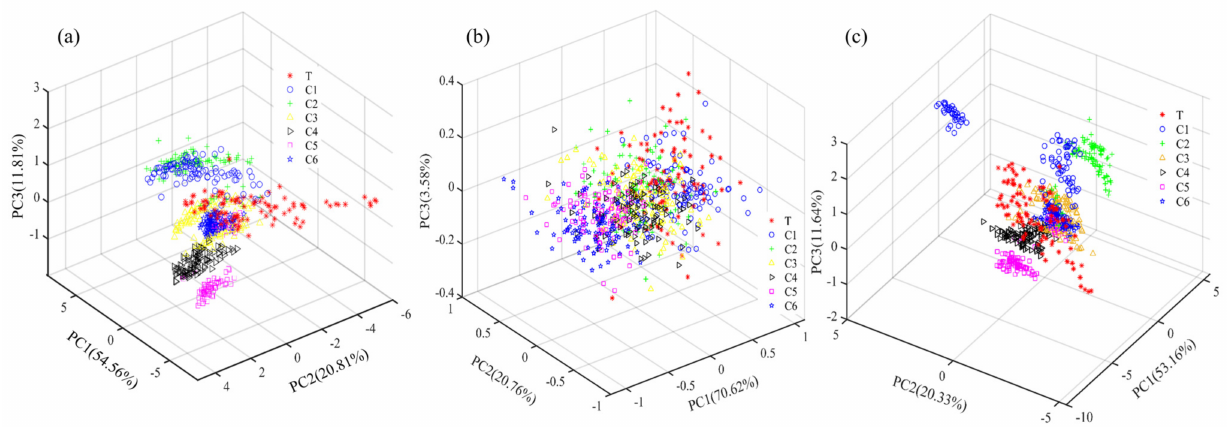
Figure 4. Three − dimensional PC distribution of seven grades of Dianhong tea samples. ( a ) ET taste features; ( b ) spectral features; ( c ) data fusion.